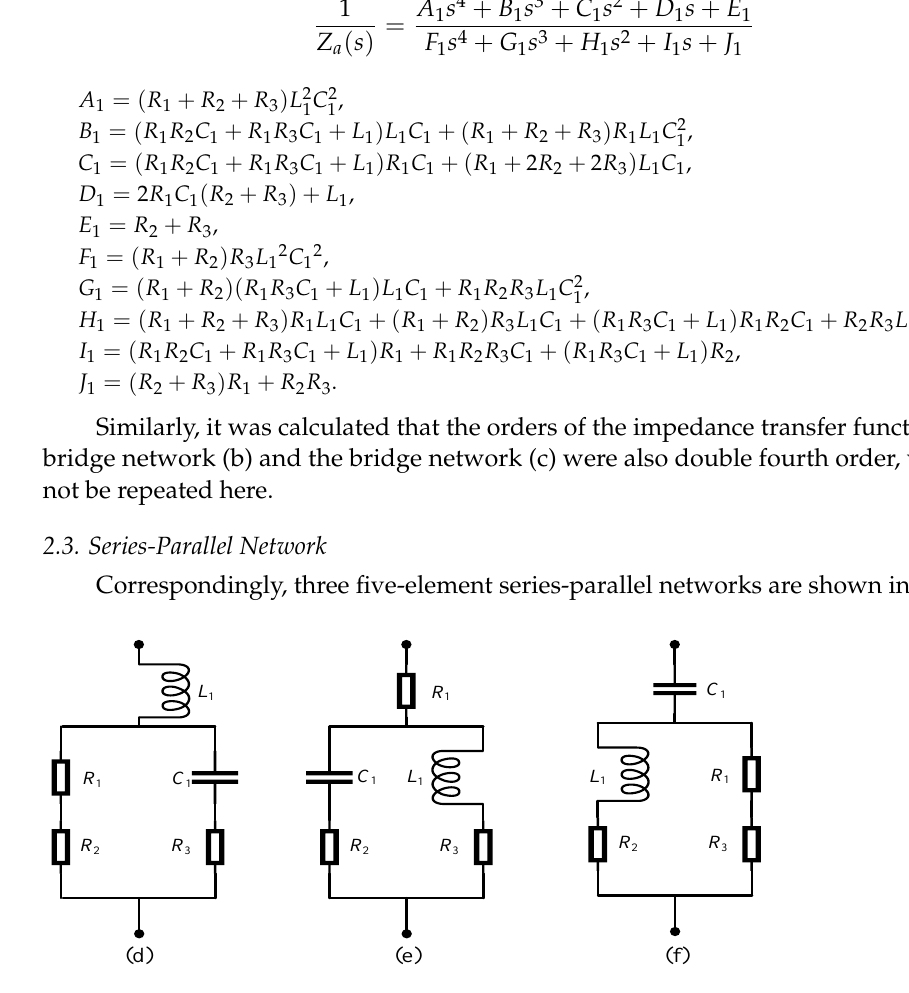
Figure 5. ( d – f ) are five-element series-parallel networks of three different